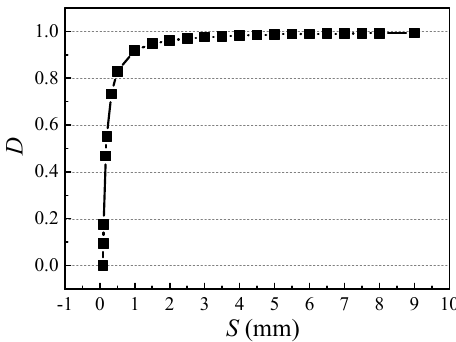
Figure 9. Damage factor vs. slip value curve.